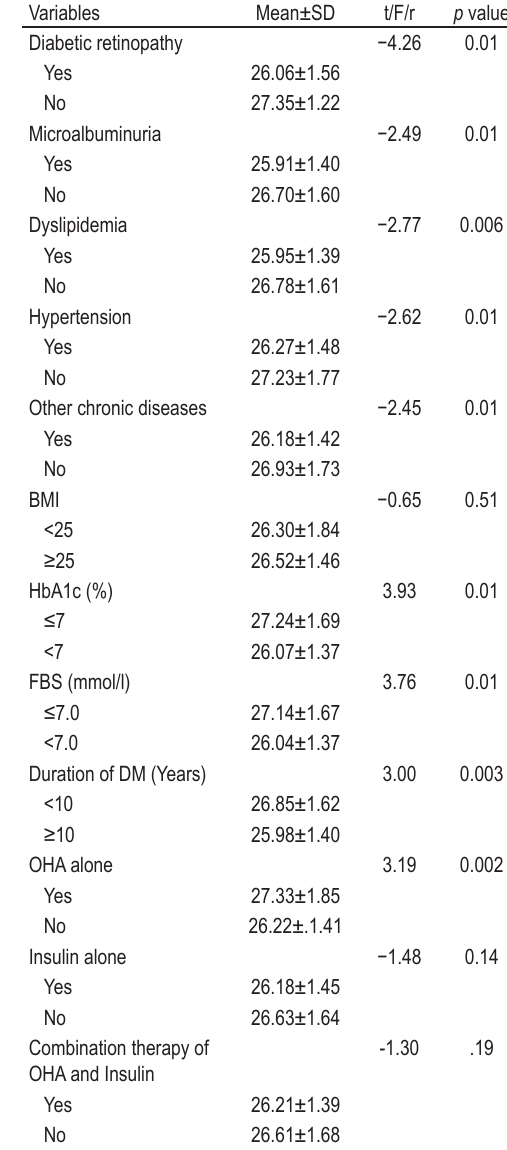
DM: Diabetes mellitus, OHA: Oral hypoglycemic agents, HbA1c: Glycated hemoglobin, FBS: Fasting blood sugar, BMI: Body mass